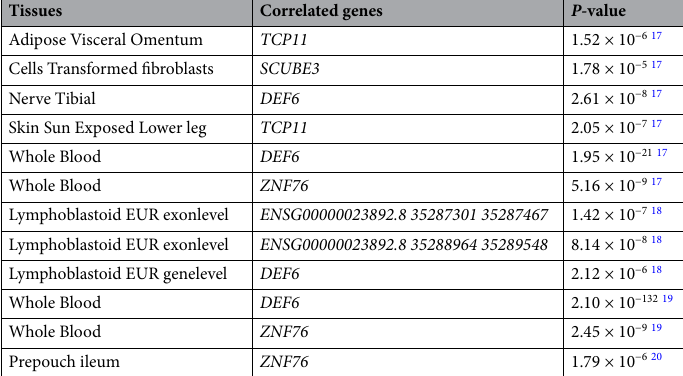
Table 3. The eQTL effect of rs10947540 in multiple tissues by HaploReg v4.1.